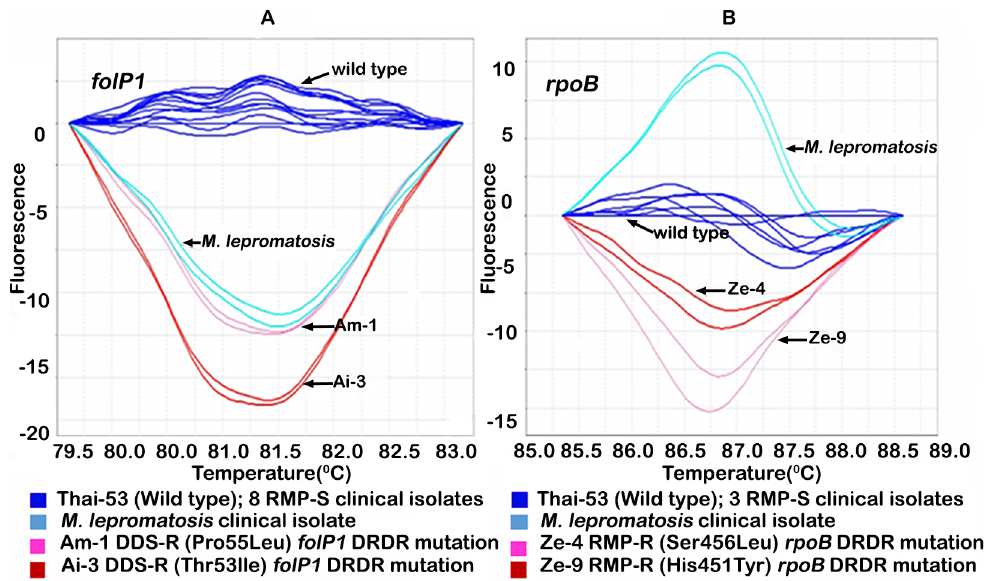
Fig 2. Comparison of M . leprae qPCR-HRM DST difference plots graphic displays of the post-qPCR HRM analysesof the rpoB and folP1 drug resistance determining regions (DRDR) of M . lepromatosis and M . leprae for DDS and RMP susceptibility. DNA meltingcurves, obtainedfrom the analysisof strains, deviate from the wild-typeprofile (Thai-53 strain, shown in dark blue color); A) folP1 DRDR HRM profiles and B) rpoB DRDR HRM profiles.